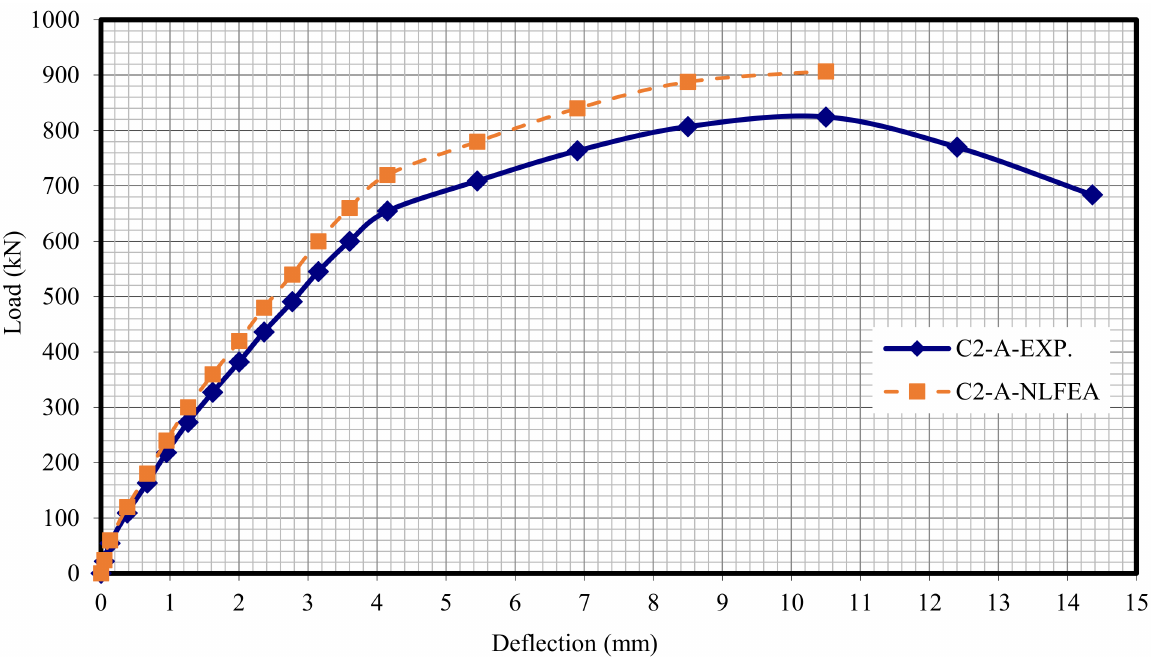
Figure 23. Load deflection of Column C2-A.